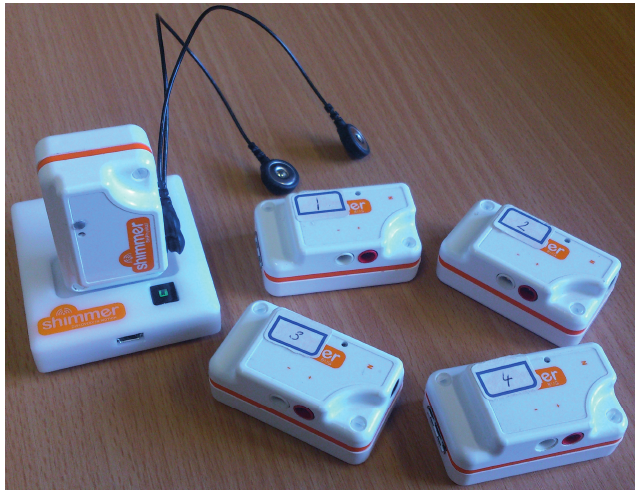
Figure 1. A collection of five Shimmer sensors used to determine the accelerometer